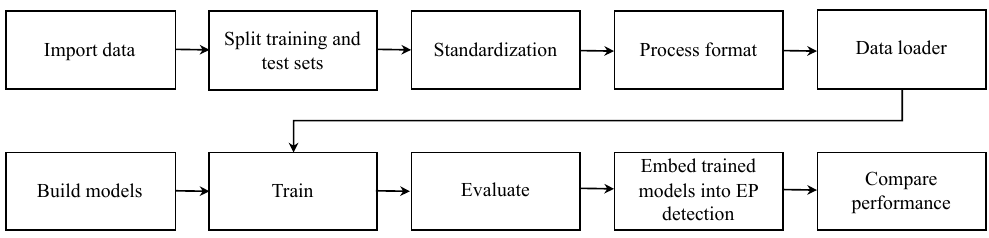
Figure 1. The process of model training and